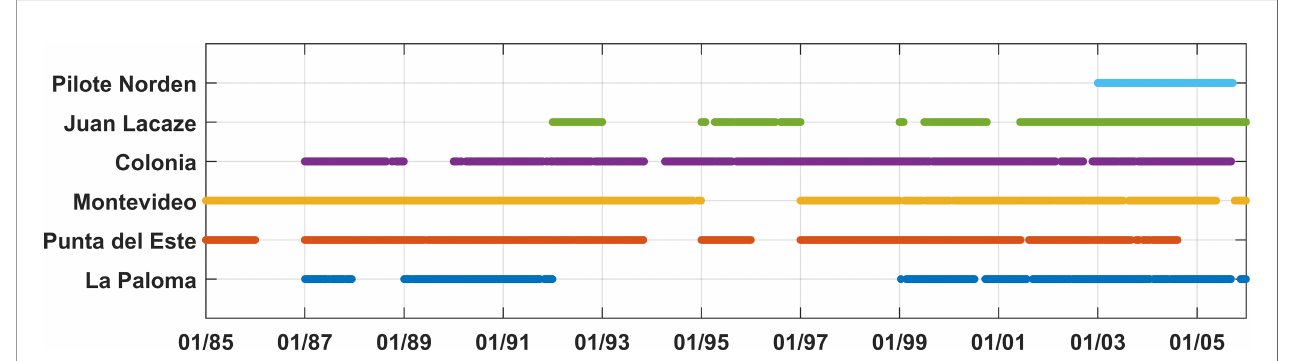
FIGURE 4 | Measured data available in each station (only years with less than 50% missing data are